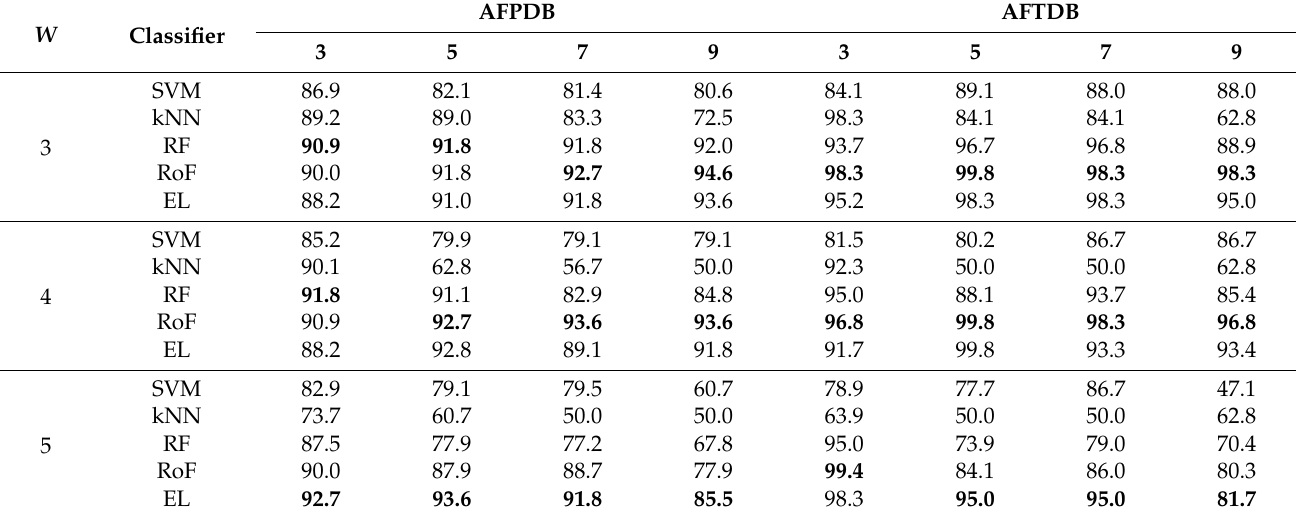
For AFPDB, the top three parameters: | V | = 9, 7, and 5 with W = 3 obtained F of 94.6%, 92.7%, and 91.8 %, respectively. Similarly, for the AFTDB database, the top three parameters | V | = 5, 7, and 3 with W = 3 yield F of 99.8%, 98.3%, and 98.3%, respectively. When the word size W is set to 3 in both databases, the F is the highest (Table 5). Moreover, the DSA feature computed using | V | and W as 3 exhibits a statistically significant difference in determining SR and PAF segments in both databases ( p < 0.005). SVM and kNN perform unreliably for varied S in both databases. EL and RoF yield the highest AUC for varied V (Figure 8). The DSA feature has a discriminative power to identify PAF segments. Based on the F, | V | and W are 3 as the optimal values for further experiments. Furthermore, this confirms our hypothesis H3. Table 5. The average F (%) for varied | V | in two databases. Bold values indicate the best performance in a group.